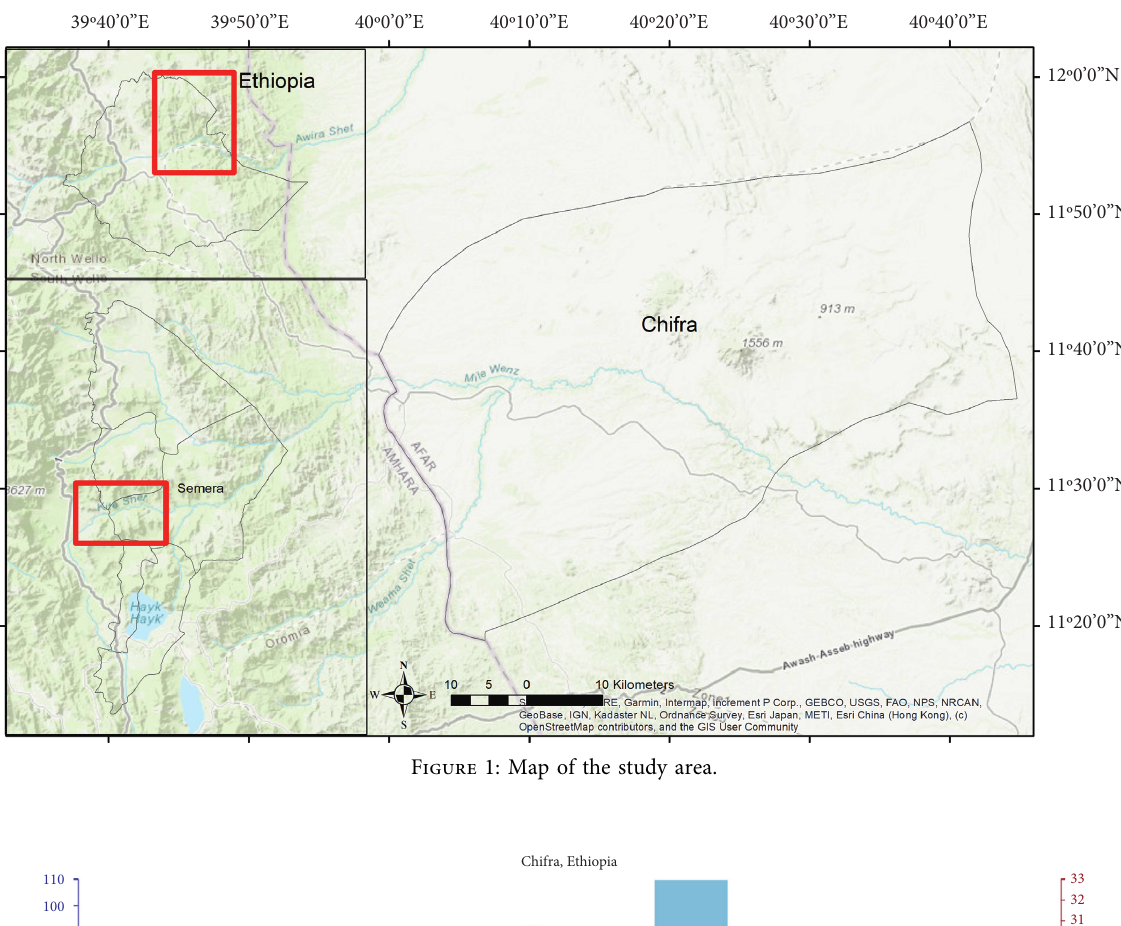
Figure 1: Map of the study